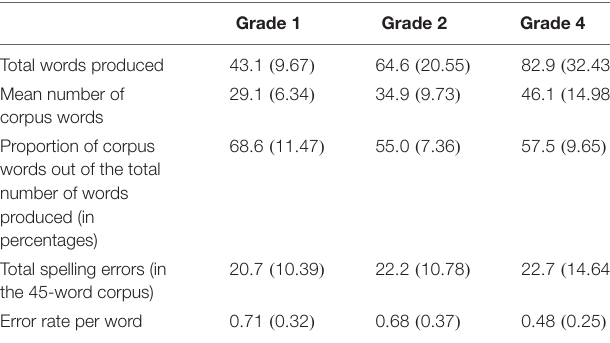
TABLE 2 | Means and standard deviations (in parentheses) of the total number of words produced per child, the mean number of words in the selected corpus of 45 key words, the proportion of corpus words out of the total number of words produced, the mean number of spelling errors in the 45-word corpus, and the error rate per word across three